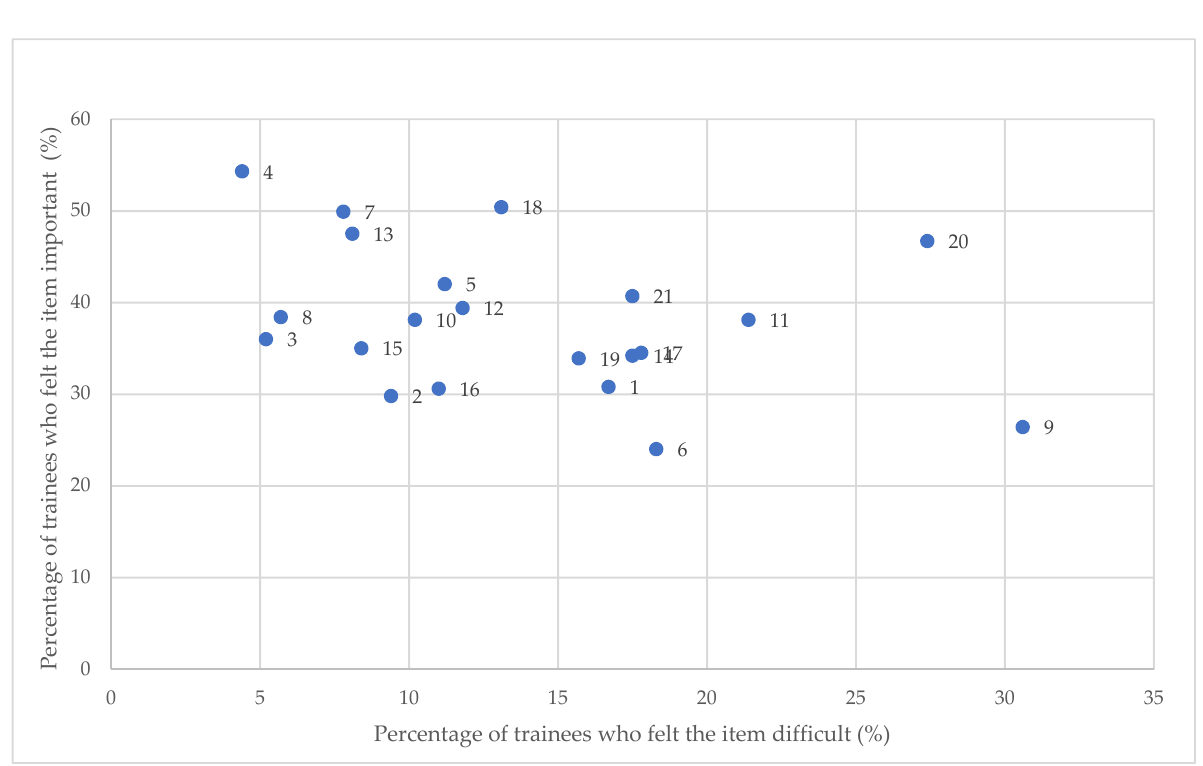
Figure A1. Correlations between Competence and Importance of Occupation Items.